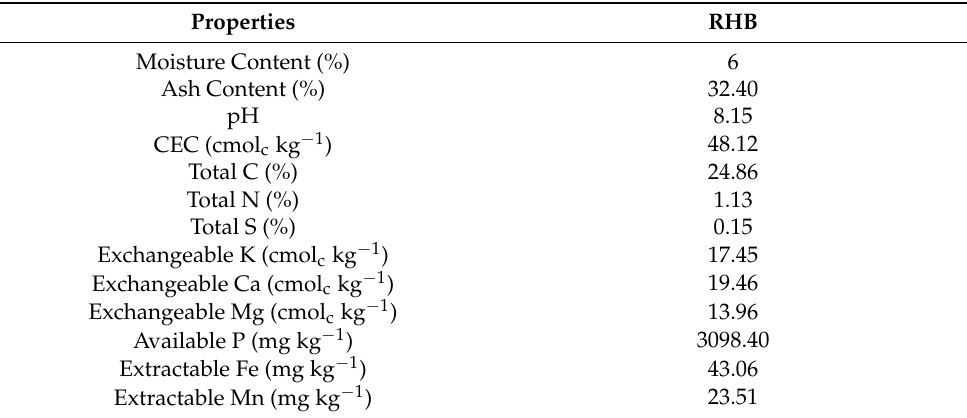
Table 2. Selected physical and chemical properties of